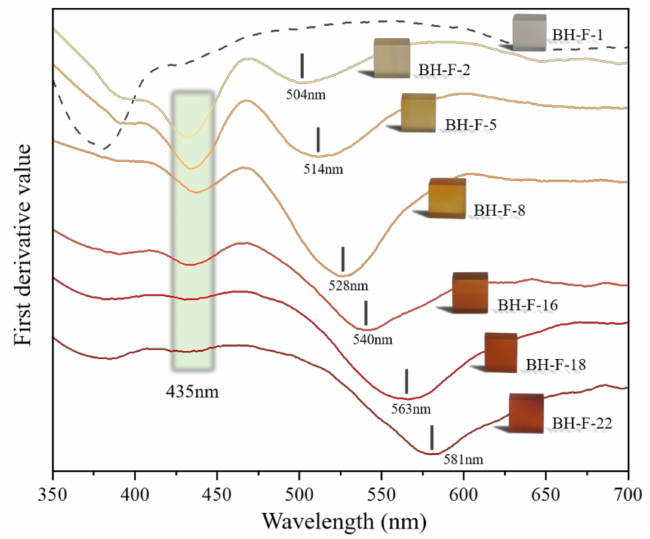
Figure 8. The first derivative curves of UV-VIS Spectra of typical Beihong agate samples and a control sample. It is worth noting that previous studies mostly take the first derivative of the reflectance spectrum, so the characteristic peaks were studied in the curve. While in this study, the absorbance spectrum was tested, so we analysed the position of the wave trough (Note: troughs occur on the shoulders of absorption bands in UV-VIS